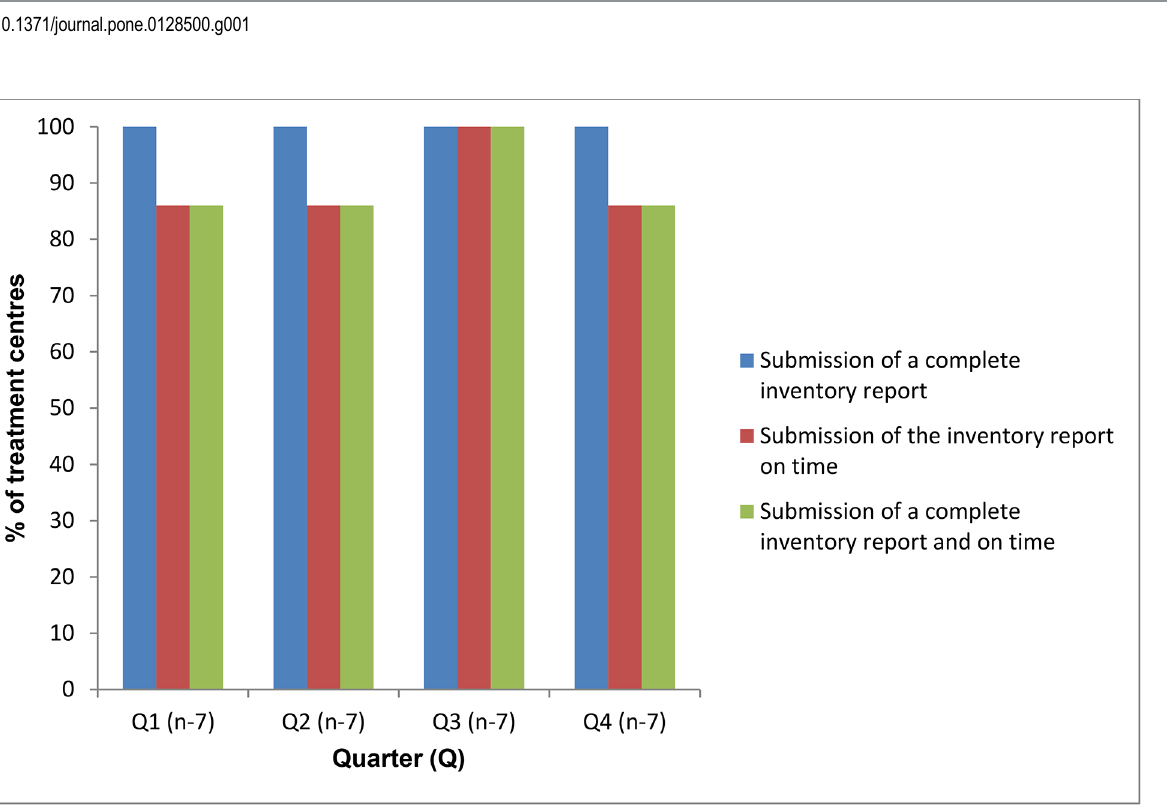
Fig 2. Proportion of treatment centres (n = 7) submitting complete inventory control reports on time for multi-drug resistant tuberculosis drugs during 2013, Nigeria (Target = 100%).